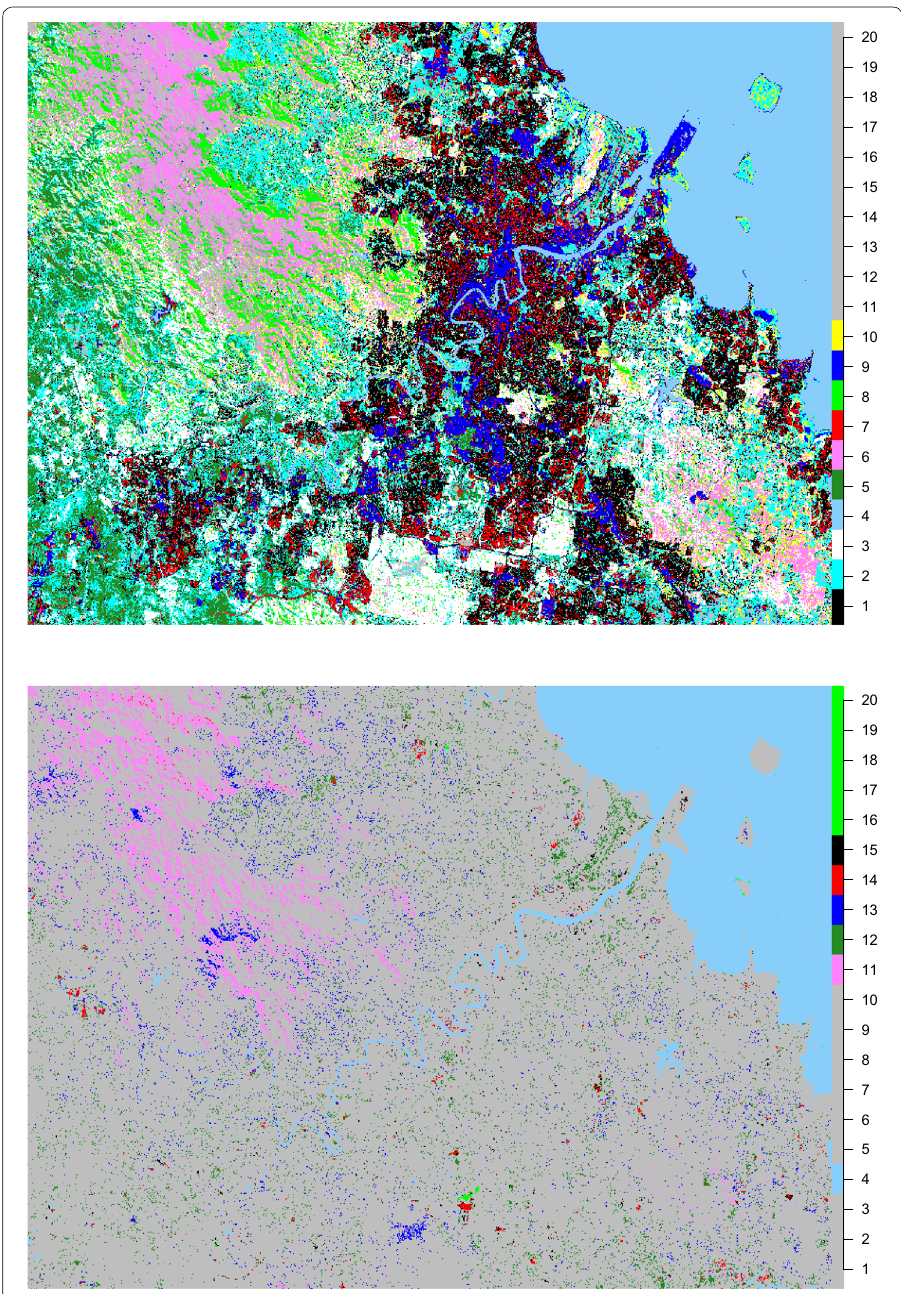
Fig. 7 Cluster analysis of satellite image of the Brisbane area taken in 2007. For clarity, some of the clusters are merged together and the results are presented in two plots: (left penal) 1: old residential areas, 2: parks, playgrounds, and grasslands, 3: forest, 4: water, 5: scrub-land, 6: mountains, 7: mostly new residential areas, 8: forest, 9: commercial buildings, and 10: forest; (right penal) 4: water, 11: mountains and forest, 12: bare ground, 13: forest, 14: disturbed earth (recent deforestation), 15: disturbed earth (recent